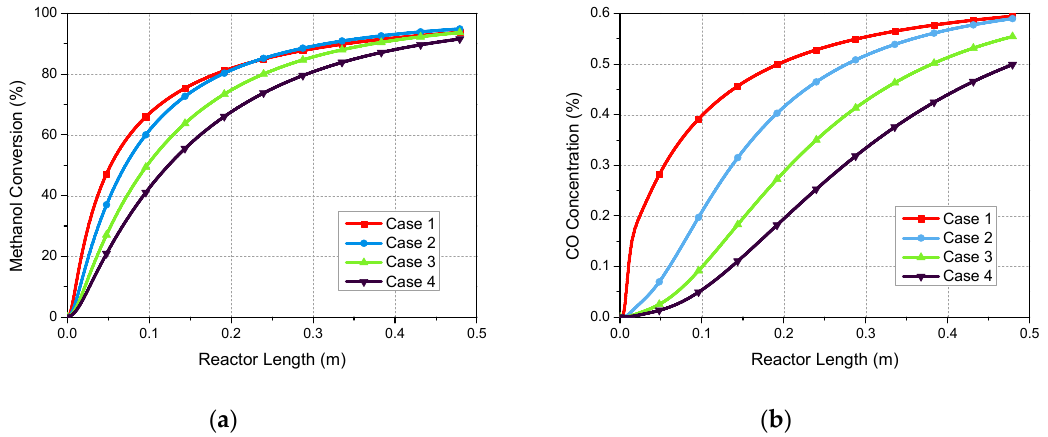
Figure 11. Temperature profiles of tube side along the length of reactor with different number and diameter of tubes.